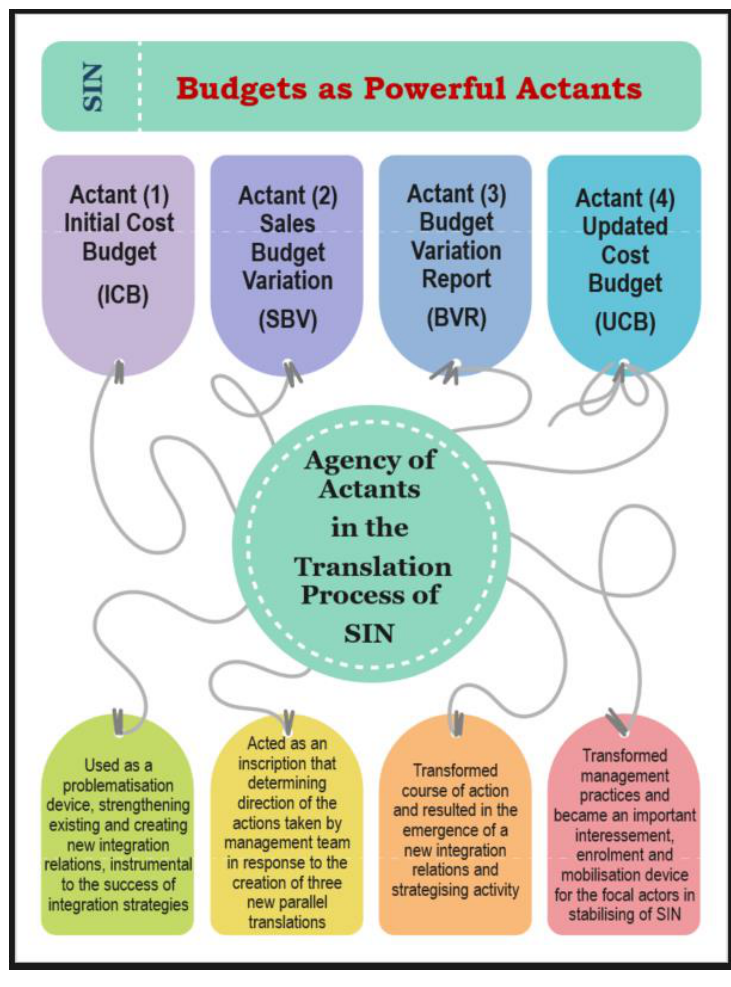
Figure 2. Summary Results.